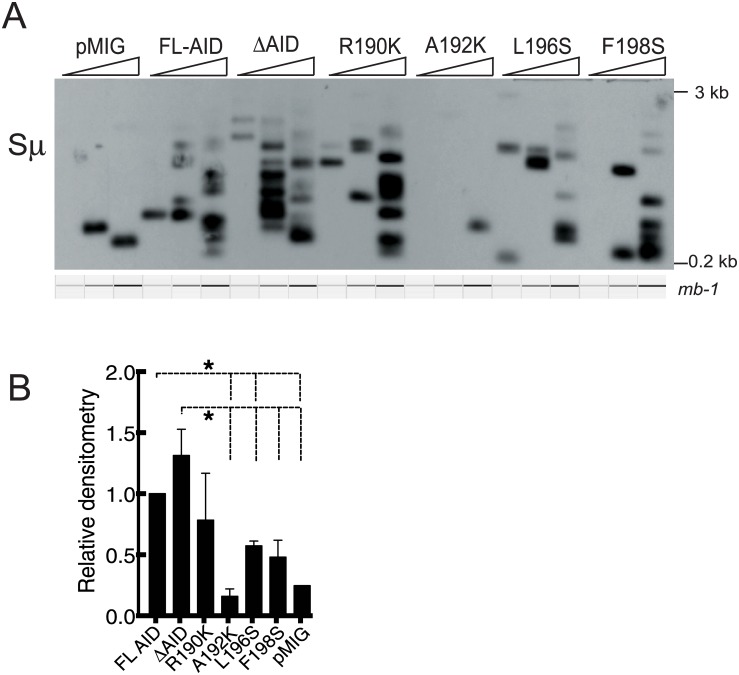
Sμ DSBs are reduced in cells expressing AID C terminus mutants.A: Southern blots of a LM-PCR assay of Sμ DSBs in aid
-/- cells induced to switch to IgG3 transduced with AID, ΔAID, the indicated mutants, or the empty retrovirus pMIG. RV transduction was performed on day 1 after activation, and cells harvested 2 days later. Three fold titrations of input DNA were assayed, and the mb-1 gene was amplified as an internal control for template input. The mb-1 PCR bands shown in A were obtained by electrophoretic analysis on a QIAxcel Advanced instrument, which subjects each sample to electrophoresis in a capillary, and provides an image of each lane. B: Quantitation of the LM-PCR signals by densitometry of all 3 lanes in 3 different experiments, normalized to FL-AID. Error bars = SEM. *p<0.04, determined by two-tailed T test.